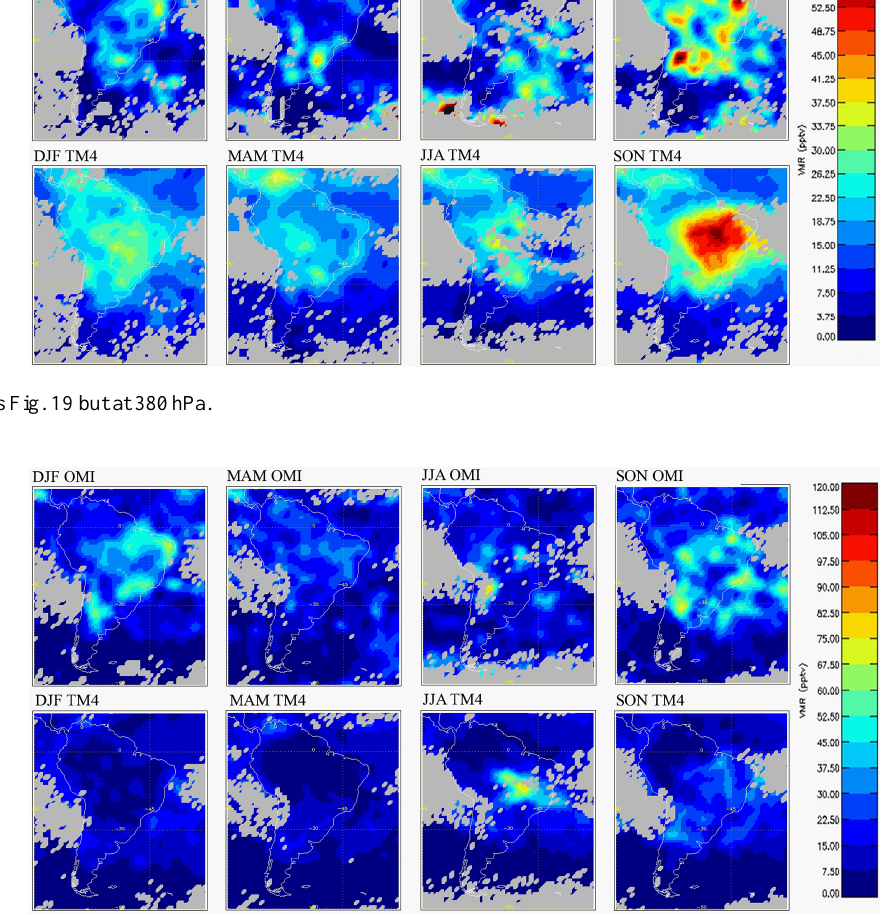
Figure 21. Same as Fig. 19 but at